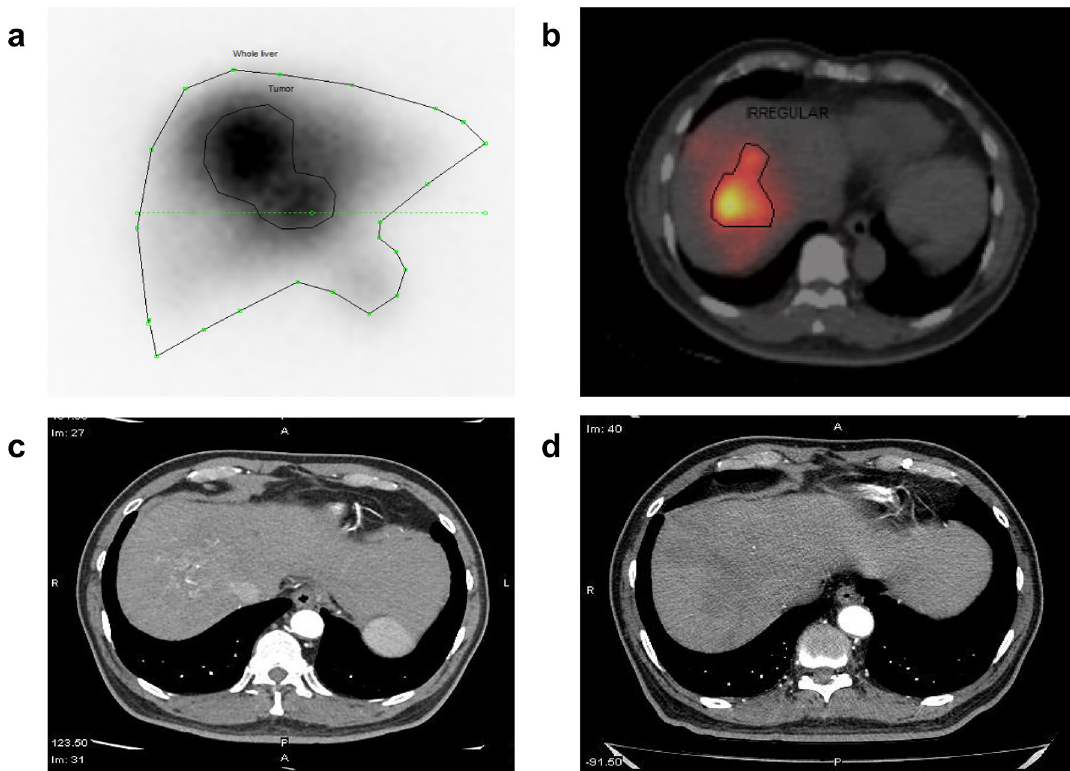
Figure 6. Images of a representative case. A 70-year-old male diagnosed with advanced stage of HCC, underwent 99m Tc-MAA planar scan ( a ) and SPECT/CT ( b ). Planar image showed only heterogeneous tumor uptake in the right liver, whereas SPECT/CT depicted better tumor margin by delineating viable tumor with excluding necrotic part ( b ). In comparison with CT before treatment ( c ), complete treatment response was seen on follow-up CT after 2 months ( d